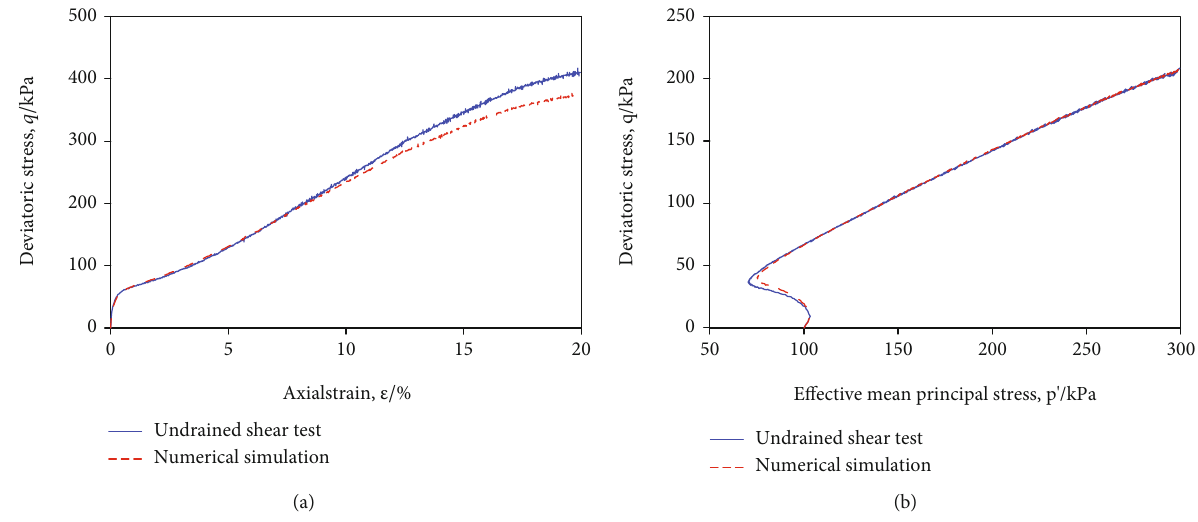
Figure 10: Deviatoric stress-axial strain curves and e ff ective stress path of undrained shear